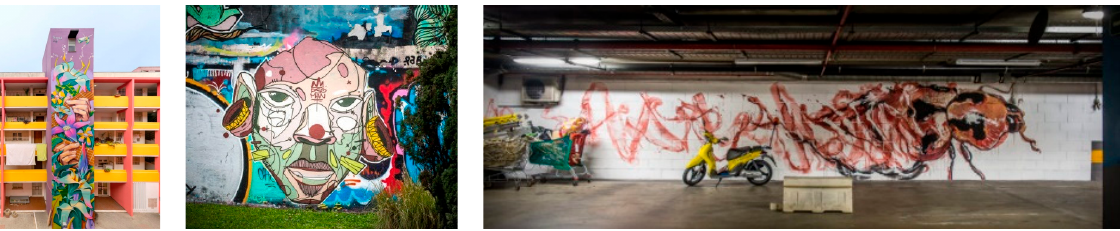
Figure 7. Dataset samples of images with street art graffiti.